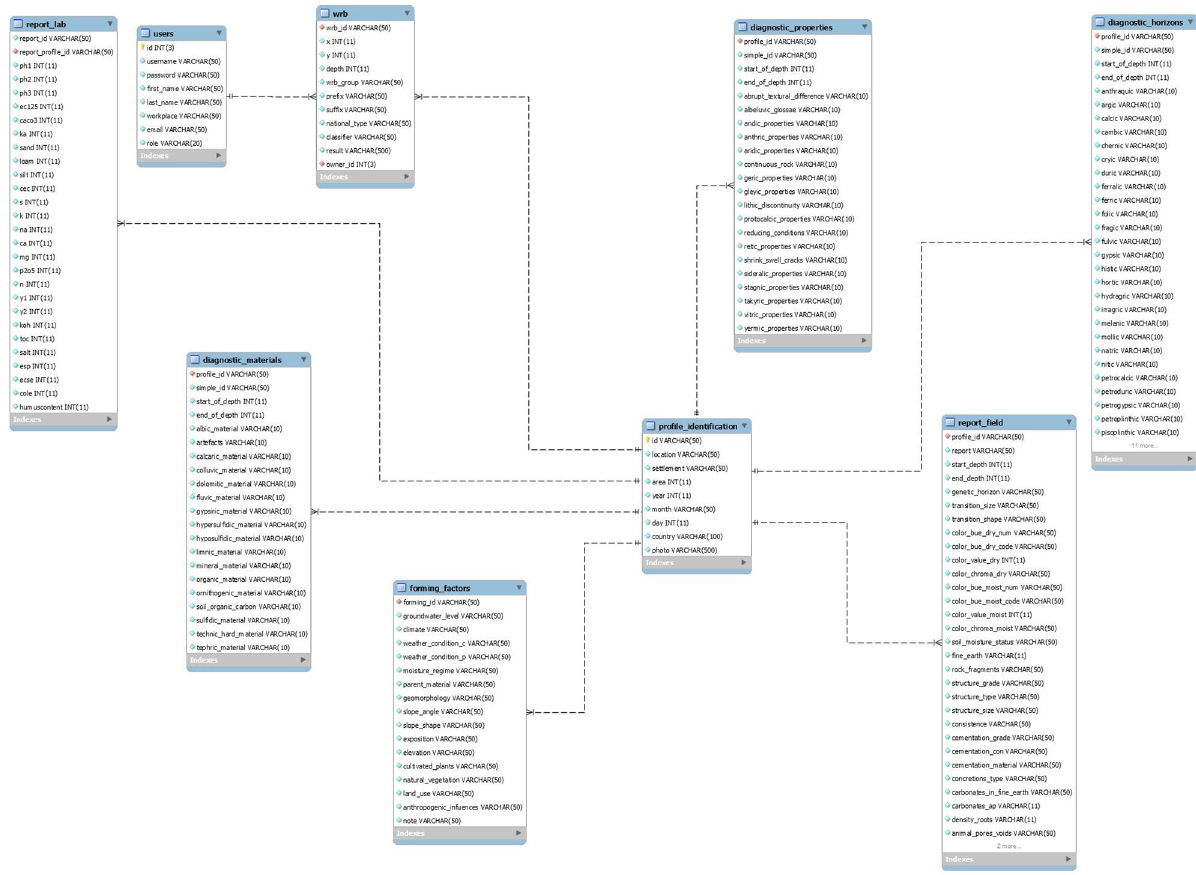
Figure 3: Database schema of SISCS.